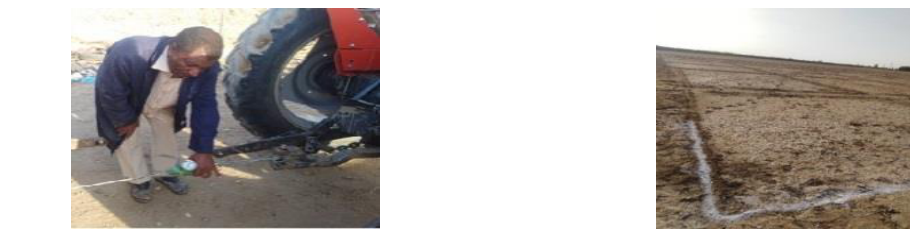
Figure 1. Test location, Food security - Atbara